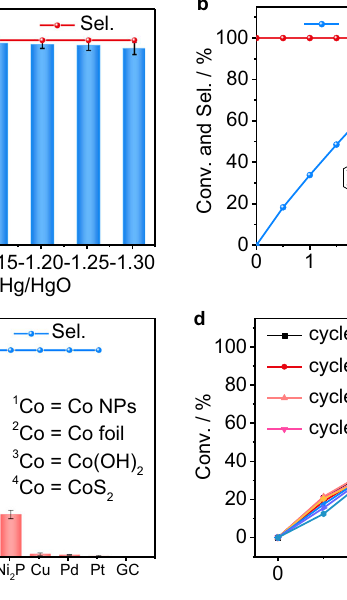
by conversion as a function of time for each cycle. Reaction conditions: 1a (0.1mmol, 14.28mmolL − 1 ), a mixed solution of 1.0M KOH/dioxane (6:1v/v, 7mL), RT. a 8h; b, c − 1.1V, 6h; d − 1.1V, 3h. Error bars correspond to the standard deviation of three independent